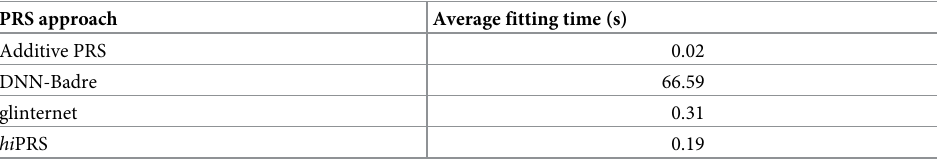
Table 1. Fitting times in a real biological setting. Fitting times for hi PRS and the benchmarks algorithms, averaged across 30 independent